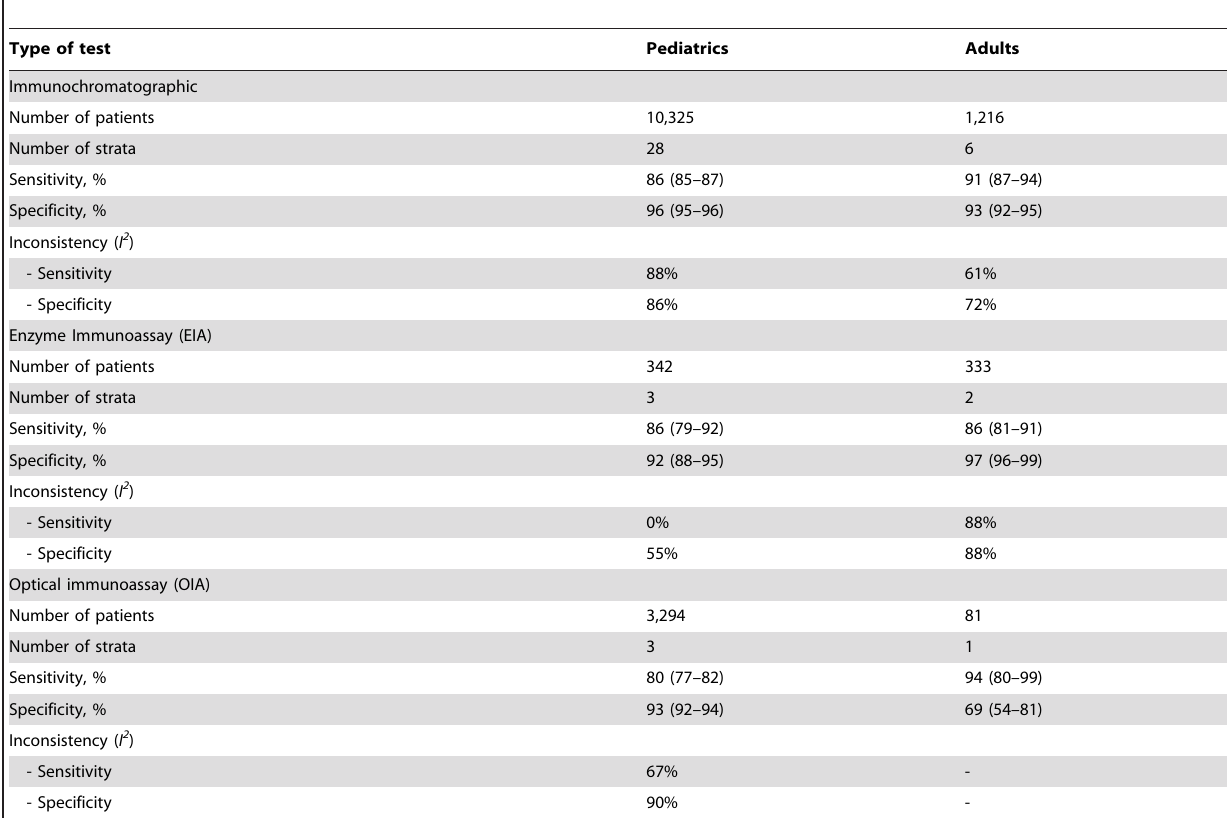
Table 1. Summary of diagnostic accuracy estimates, higher study methodological quality*.